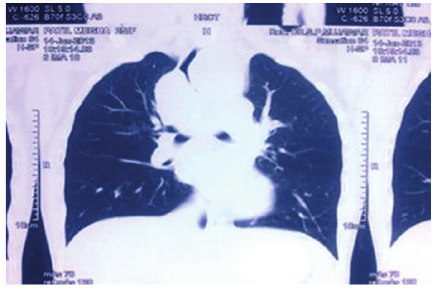
Figure 3: CT scan image.